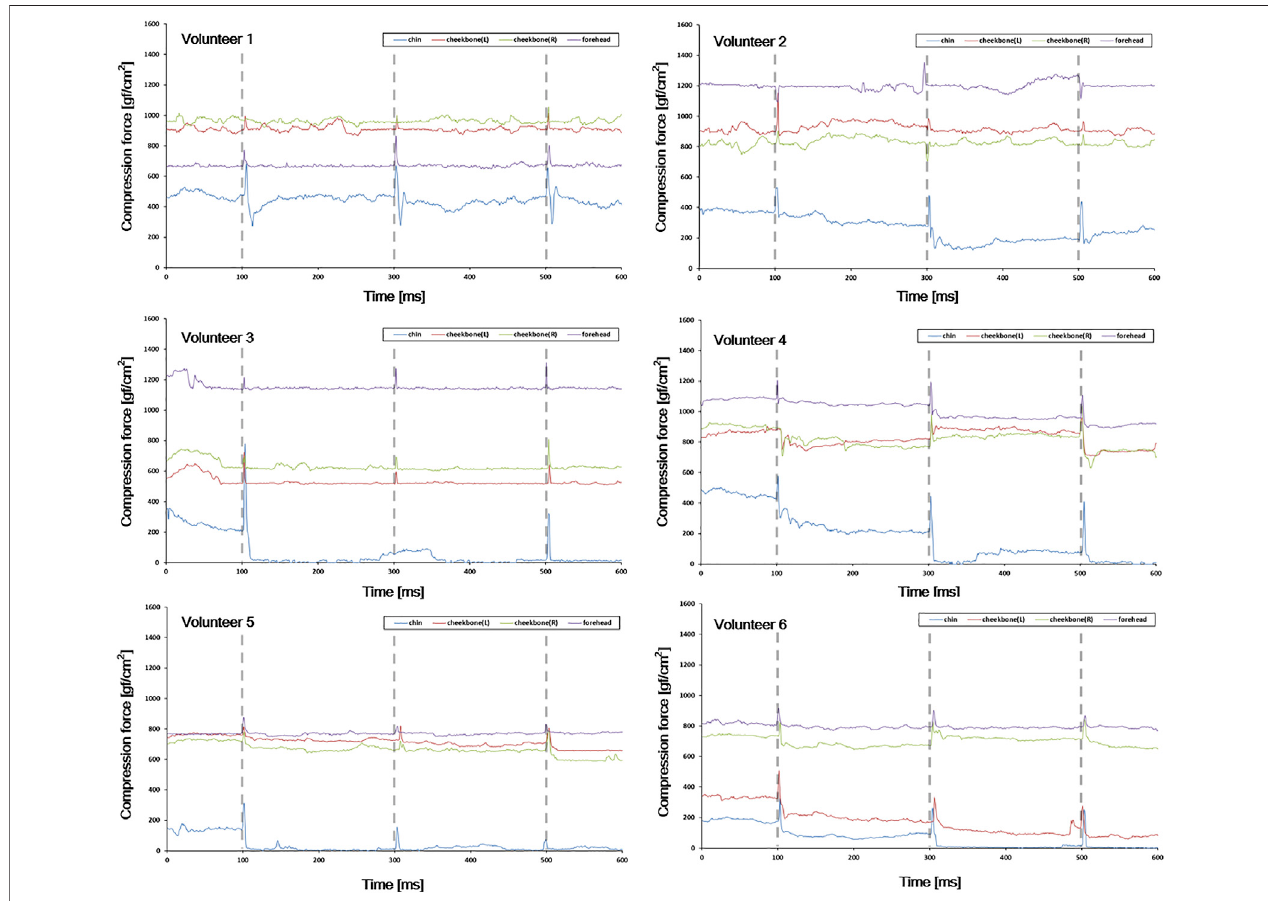
FIGURE9| Compressionforcevariationduetointendedmotioninsidethethermoplasticmask.Thegrayverticaldottedlineindicatesthetimeatwhichtheintended motion was instructed (10, 30, and 50 s after monitoring starts).